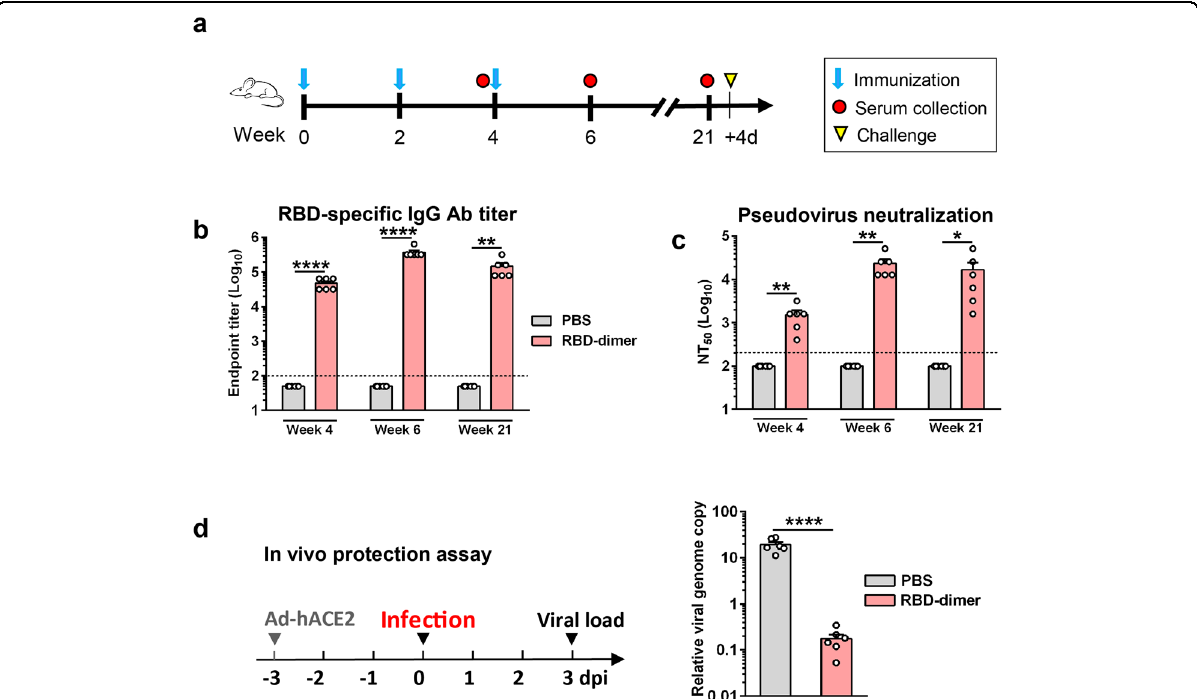
Fig. 5 Yeast-derived RBD-dimer elicited durable protective antibodies in mice. a Schedule of mouse immunization and challenge experiments. Two groups of six BALB/c mice were immunized with alum-formulated RBD-dimer protein (5 μ g/dose) or PBS at weeks 0, 2, and 4. Serum samples were taken at weeks 4, 6, and 21. Four days after the last serum collection, the mice were challenged with live SARS-CoV-2. b RBD-speci fi c antibody titers in the antisera were measured by ELISA. Anti-PBS sera did not show any binding activity at the lowest serum dilution (1:100; dashed line) and was assigned a titer of 50. c Neutralizing antibody titers of the antisera against SARS-CoV-2 pseudovirus. Anti-PBS sera did not show any neutralization at the lowest serum dilution (1:200; dashed line) and was assigned a NT 50 value of 100. d Active immunization with RBD-dimer provided protection against live SARS-CoV-2 infection. Left panel: study outline. After transduction with Ad5-hACE2, the vaccinated mice were challenged with live SARS- CoV-2 and then analyzed for viral loads in the lungs by qRT-PCR. Right panel: qPCR results are shown as viral RNA levels relative to GAPDH, using 2 − Δ Ct method. Each symbol represents one mouse. For panels b – d , data are presented as means ± SEM. P values were analyzed with unpaired t -test and indicated as follows: * P < 0.05; ** P < 0.01; **** P <